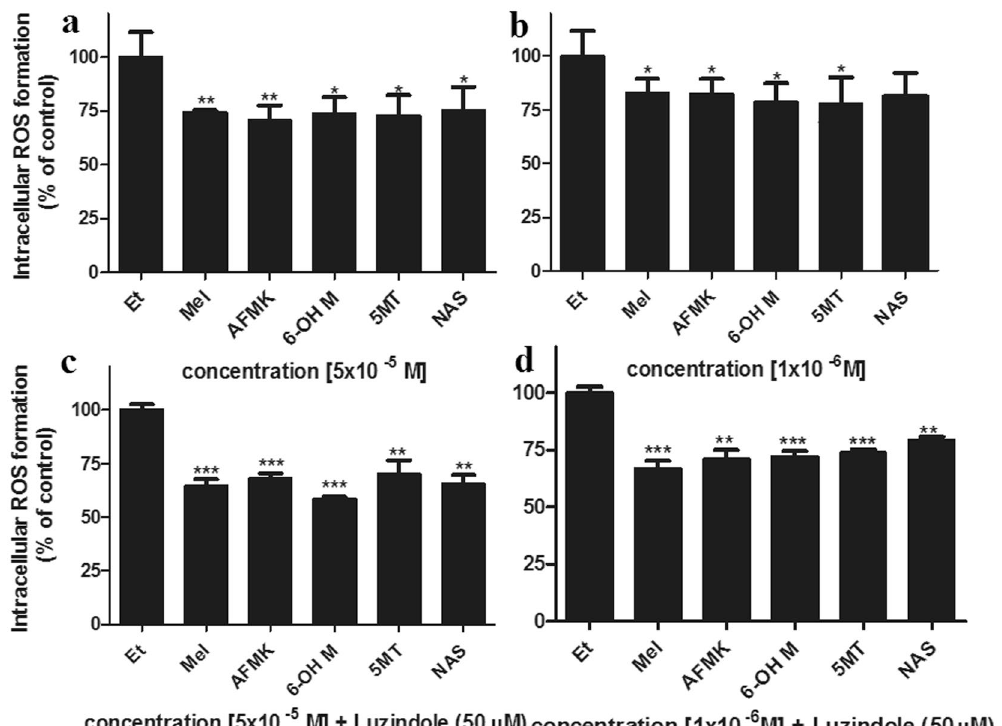
Figure 5. Melatonin, NAS, 6-OHM, AFMK, and 5-MT reduce levels of ROS produced in UVB-irradiated melanocytes. Cells were treated without ( a , b ) or with ( c , d ) luzindole 1 h prior treatment with melatonin, AFMK, 6-OHT, 5-MT, NAS, or EtOH for 1 h at the concentrations of 5 × 10 − 5 M ( a , c ) or 1 × 10 − 6 M ( b , d ). CM- H2DCFDA dye was added to the cells for 30 min and cells are further irradiated with 50 mJ/cm 2 of UVB. ROS levels in melanocytes were determined 30 min after UVB irradiation. The differences in H 2 O 2 production under different UVB intensities are shown as insert. Data are presented as percent of control and were analyzed using